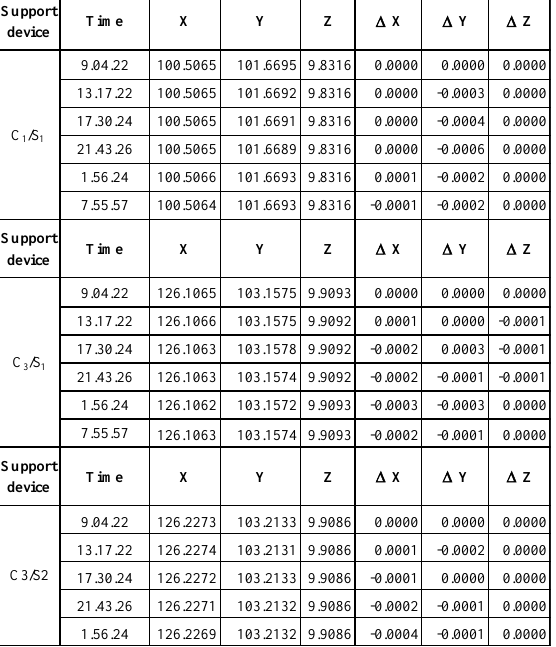
Table 1. Coordinates (in meters) of the control points